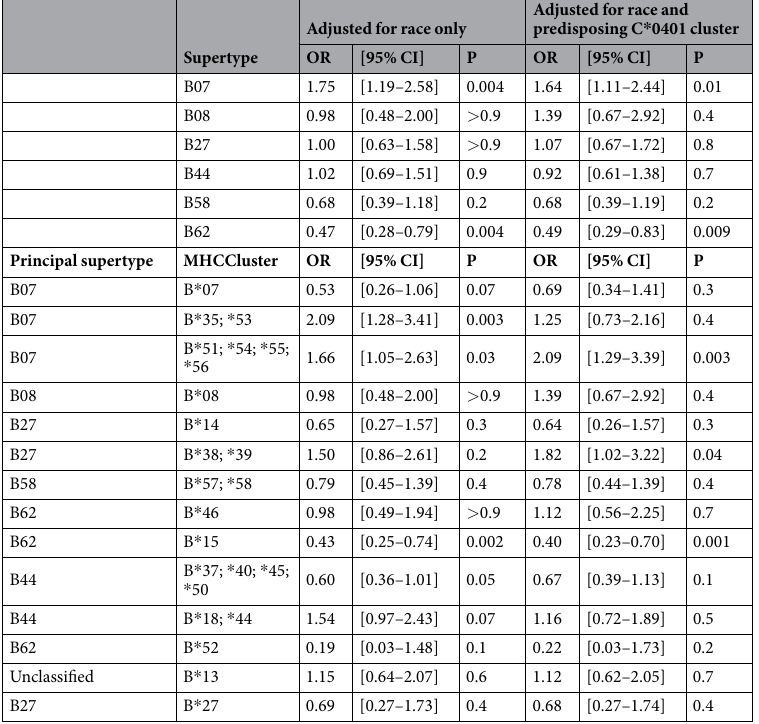
motif Tyr7-Tyr9-Ala24-Val34-(Met/Thr)45-Glu63-Ile66-Ser67-Asn70-(Tyr/Phe)99 is characteristic of a cluster of HLA-B B62 supertype alleles: HLA-B * 15: ( 01 /12/24/25/27/35) and HLA-B * 52: 01 (Figure S3 and Table S2), con- sistent with a previously reported protective HLA-B * 15 association with cutaneous NVP reactions observed in an Indian population 34 . However, in this dataset the strength of the protection is diminished when the HLA B62 supertype as a whole is considered or if HLA-B * 52:01 is excluded (Table 1). It appears that the protective prop- erty of this HLA B62 sub-group is driven by the common B pocket structure of the binding groove. Other HLA